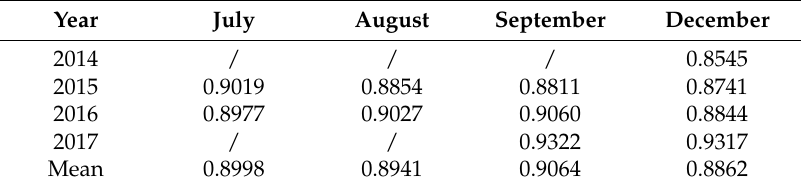
Table 3. The Jaccard similarity coefficient of the total area within the DDG boundaries derived for the Sentinel-1A coherence maps selected around July, August, September and December with respect to the Sentinel-2B optical image.